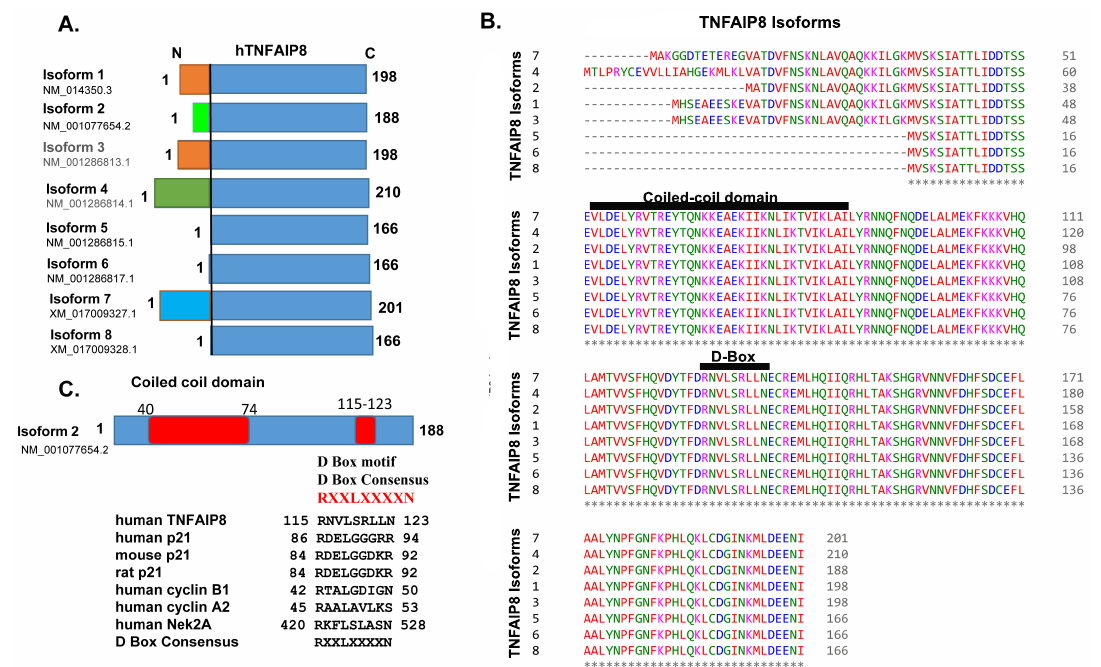
Figure 2. ( A ) Amino acid sequences of human TNFAIP8 (hTNFAIP8) protein isoforms are presented. The variable N-terminal region is shown in different colors. ( B ) Amino acid sequence alignments of hTNFAIP8 protein isoforms. The highly conserved coiled-coil structural motif and D-Box (destruction box) consensus are shown. (https://www.ebi.ac.uk/Tools/msa/clustalo/, accessed on: 5 October 2018). ( C ) Location of the coiled-coil domain and D-Box consensus on TNFAIP8 isoform 2 are presented. D-Box amino acid consensus of TNFAIP8 and other known D-Box motif-containing proteins are